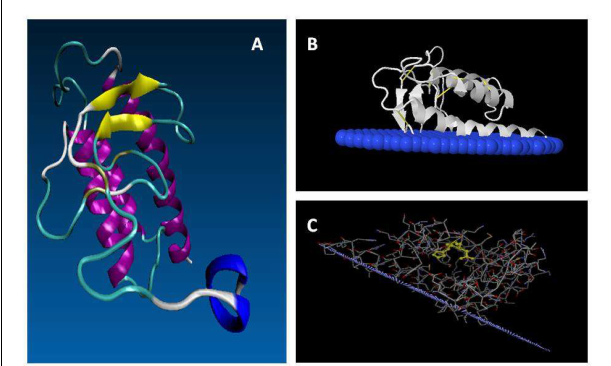
FIGURE 5 | Putative mature structure of GmsPLA 2 -XIA-I. (A) Proposed structure from homology modeling of GmsPLA2-XIA-I (Mariani et al., 2012). Yellow: beta sheet strand; magenta: alpha-helix; blue: C-terminal; cyan: turns; white: coils. (B,C) Molecular simulation of the interaction between Gm sPLA 2 -XIB-II with the membrane interface, simulated with the OPM (Orientation of Proteins in Membrane) database online service (opm.phar.umich.edu/; see Lomize et al., 2012). In panel (B) blue: interfacial membrane; white: protein. (C) Light purple represents the interfacial membrane; the sticks denote the protein amino acids with the H/D dyad highlighted in